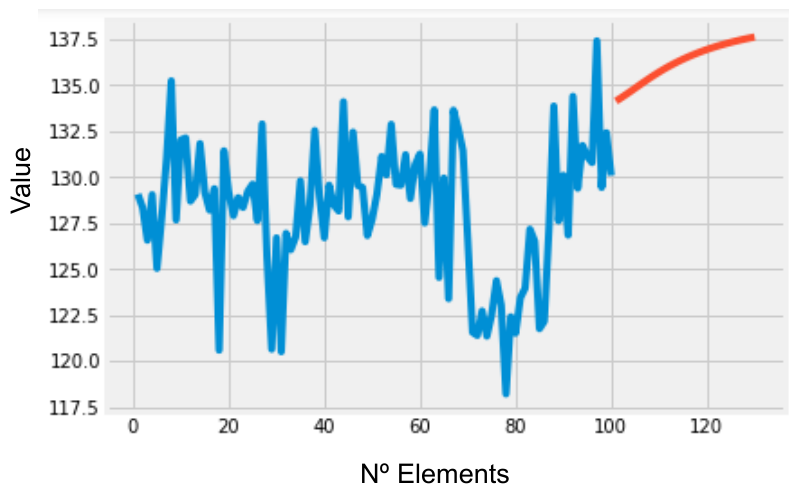
Figure 13. Forecasted values for the initial sequence.